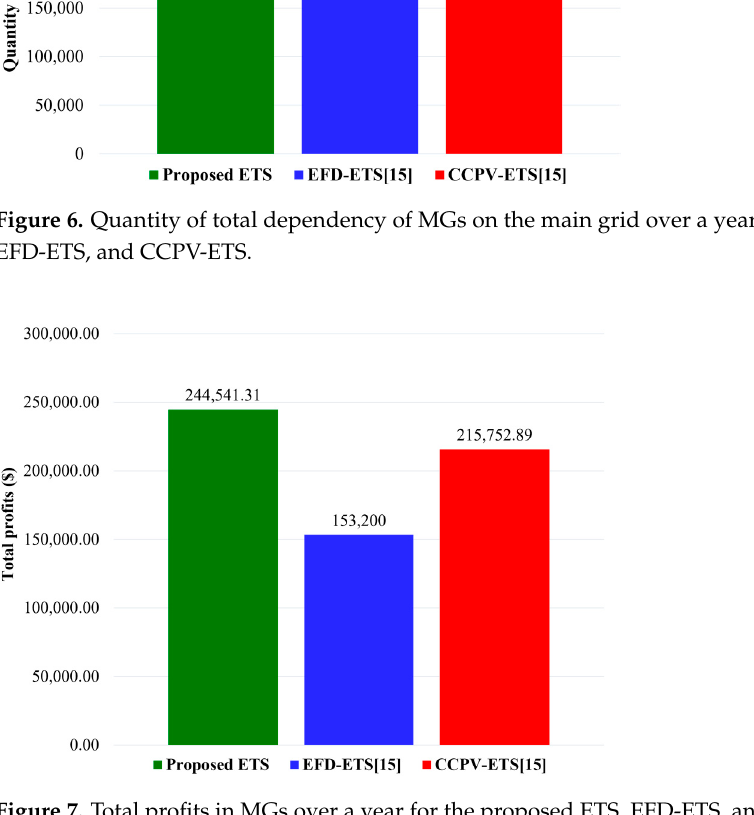
Figure 6. Quantity of total dependency of MGs on the main grid over a year by the proposed ETS, EFD-ETS, and CCPV-ETS.